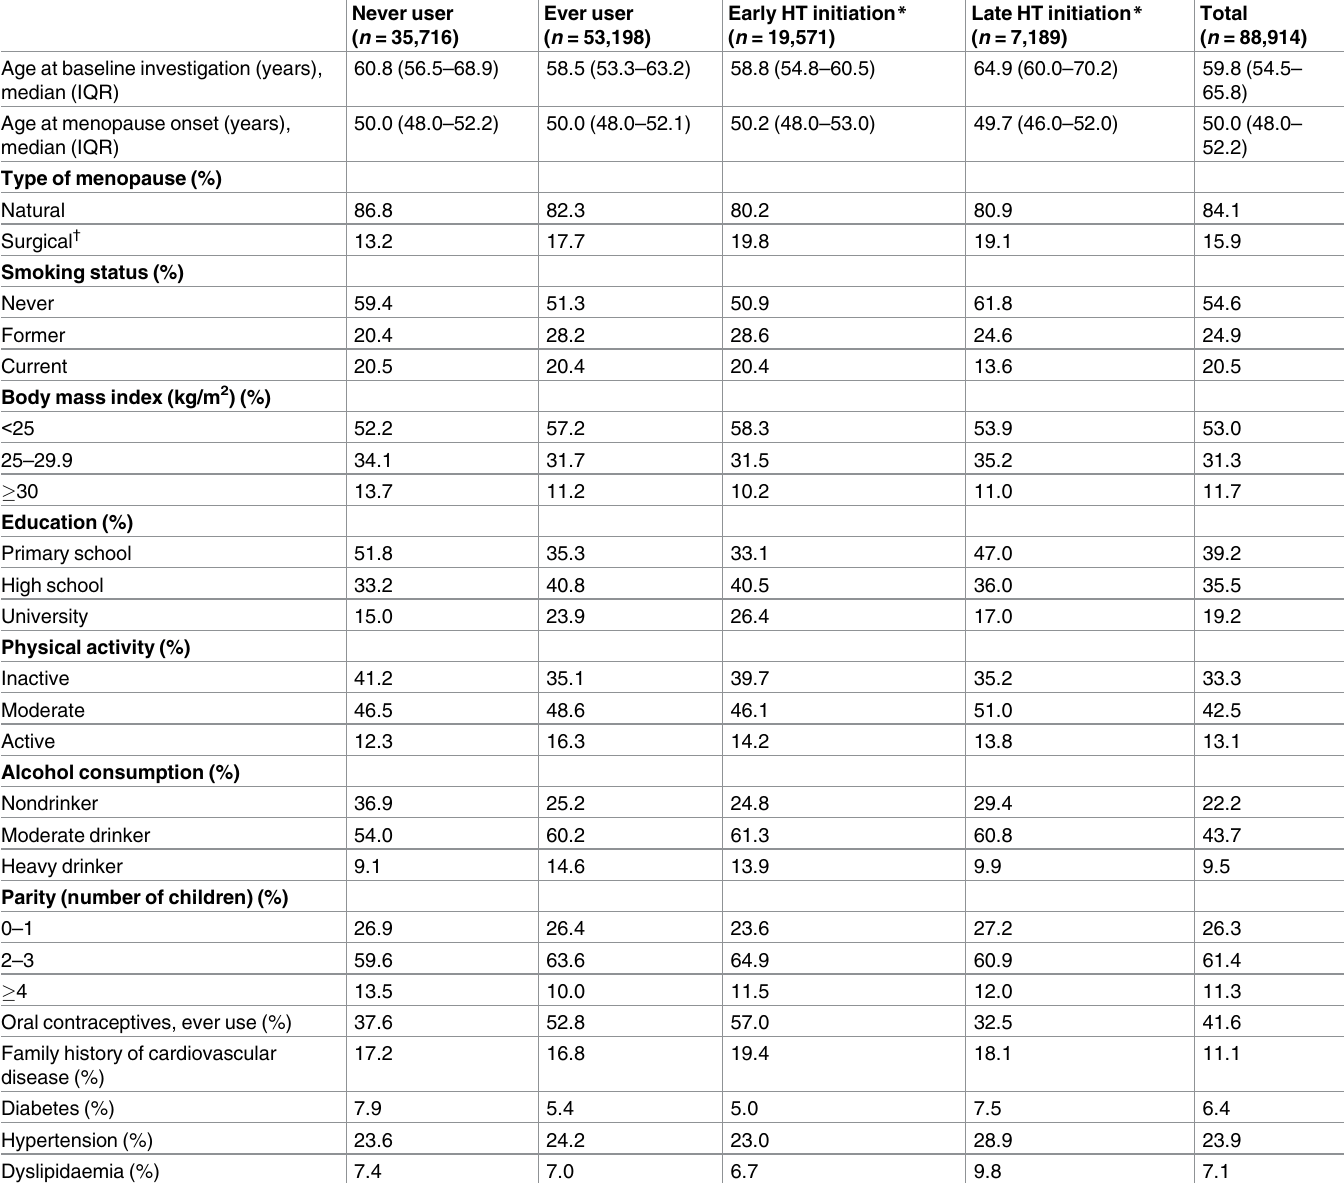
Table 1. Baseline characteristics of the postmenopausal women included in the present study of the Combined cohorts of menopausal women— Studies of register-based health outcomes in relation to hormonal drugs (COMPREHEND)